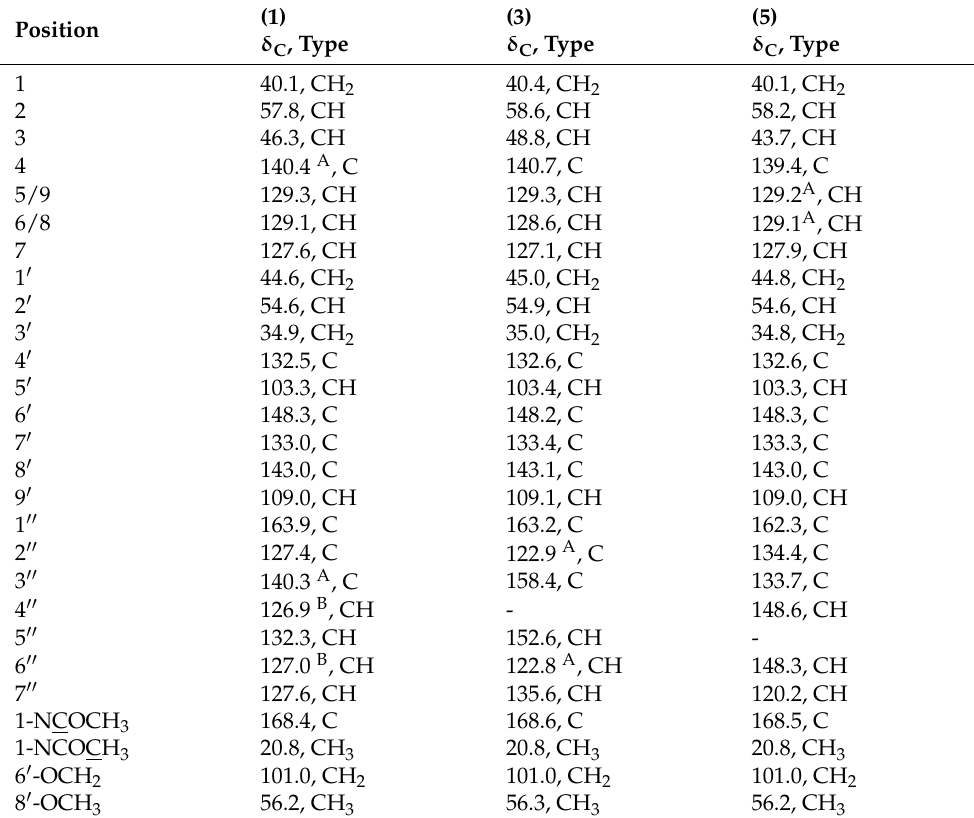
nicotinamide in 3 and N -isonicotinamide in 5 . These observations were confirmed by diagnostic 2D NMR correlations (Figure 5) together with chemical shifts and multiplicities for chiral centre methines in 3 (H-2 δ H 3.87, ddd, J 11.2, 8.8, 3.8 Hz; H-3 δ H 4.56, d, J 8.8 Hz; H a -3 ′ δ H 2.90, dd, J 13.5, 8.3 Hz; H b -3 ′ δ H 2.86, dd, J 13.5, 6.3 Hz), and 5 (H-2 δ H 3.92, ddd, J 14.5, 10.3, 3.7 Hz; H-3 δ H 4.56, d, J 10.3 Hz; H a -3 ′ δ H 2.90, dd, J 13.4, 8.6 Hz; H b -3 ′ δ H 2.85, dd, J 13.4, 6.4 Hz), which together with biosynthetic considerations permitted assignment